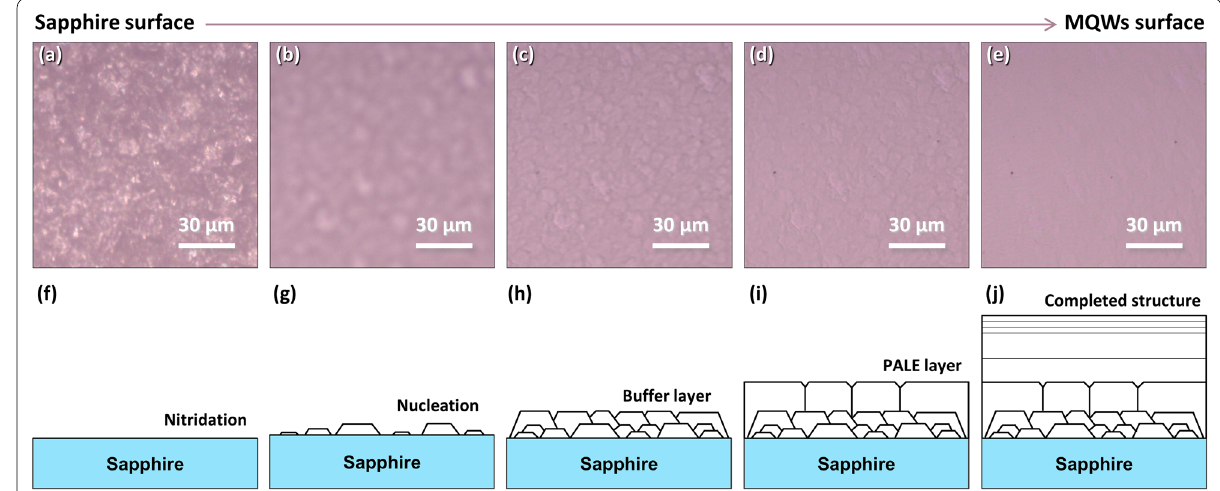
Fig. 3 a – e Optical micrographs of the MQWs sample with the focus points changed from the sapphire surface to the MQWs surface. One can observe that the grain size is similar with the emission pattern in the monochromatic CL mapping images. f – j The schematic of two-step epitaxial growth process for nitride